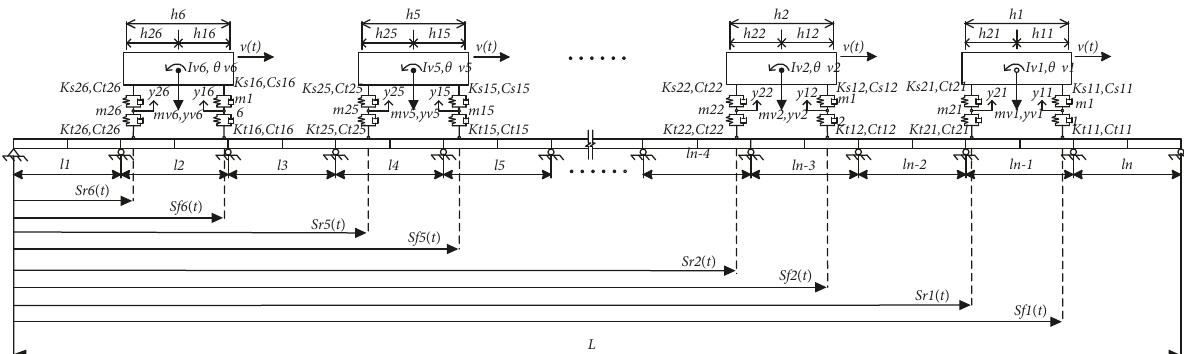
Figure 1: Train-structure system of n -span continuous beam.